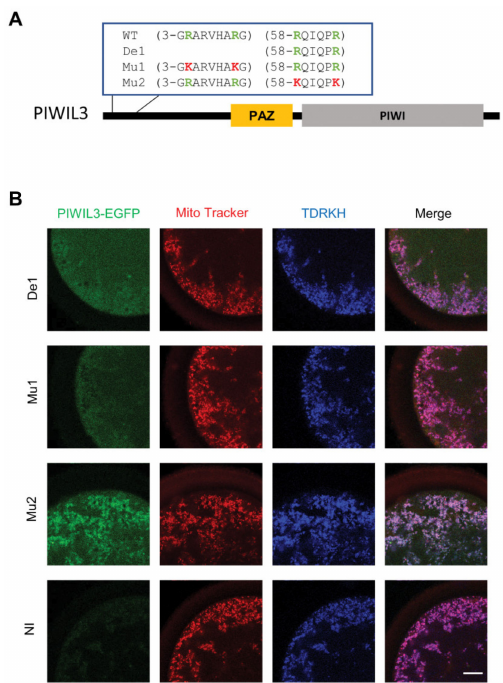
Figure 4. The N-terminal domain of PIWIL3 is critical for binding with TDRKH. ( A ) Domain map of PIWIL3 mutation construct. WT: wild type PIWIL3 sequence. De1: deletion construct lacking N-terminal GRARVHARG. Mu1 / Mu2: mutation vectors. Green: original arginines; red: R → K substitutions. ( B ) Triple labeling of PIWIL3-EGFP mutants (green), mitochondria (red), and TDRKH (blue) in oocytes. Coding on the left indicates injected mRNAs. NI: non-injected oocytes. Scale bar, 20 µ